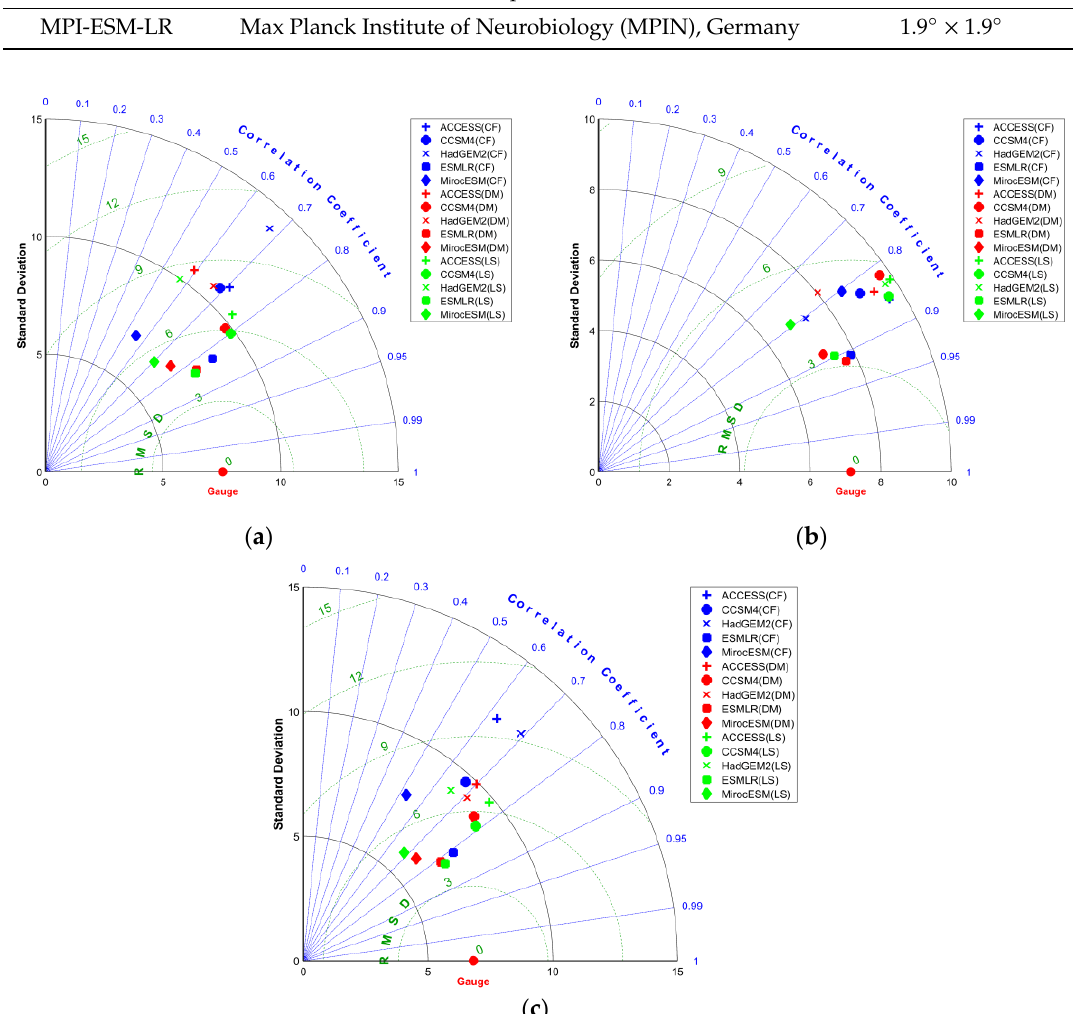
Figure 3. Inter-comparison of the results of downscaling techniques; ( a ) maximum temperature, ( b ) minimum temperature, ( c ) precipitation. Table 3. Description of the selected global climatic model used in this research.